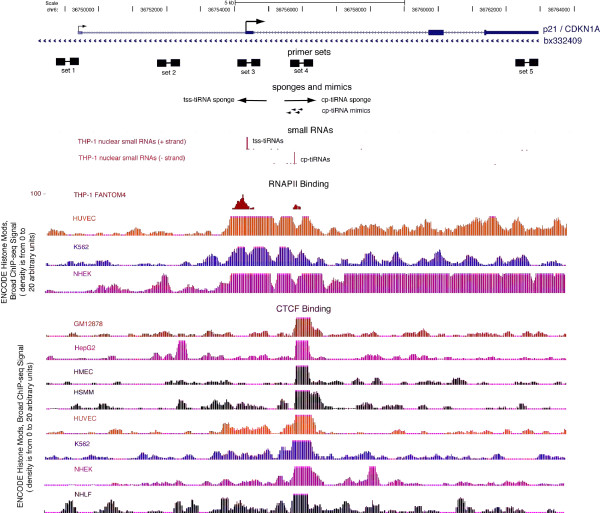
Schematic depicting the p21 (cyclin-dependent kinase inhibitor 1A gene, also known as CDKN1A) locus. The blue lines, boxes and arrows at the top of the image show the p21 and antisense transcripts. Small black boxes connected by black lines depict the five primer pairs used in this study. THP-1 small RNAs (sRNAs) are shown as a density plot in red, followed below by RNA polymerase II (RNAPII) binding from multiple cell types, and CCCTC-binding factor (CTCF) binding across eight cell types. The THP-1 nuclear sRNA deep sequencing data is the deepest sRNA dataset currently available and was therefore, given the conservation of the CTCF site, was used as the basis for the sponge and mimic constructs in all cell lines.